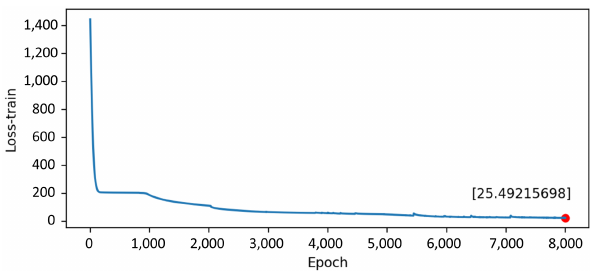
Figure 13. The training